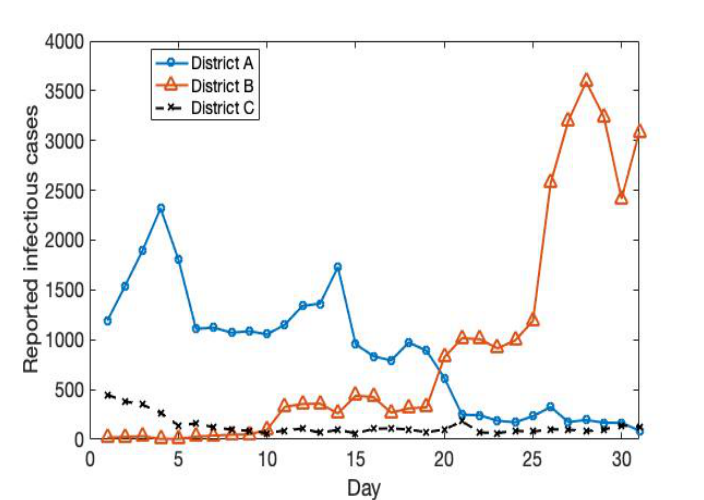
Figure 2. The infections cases during 31 days.